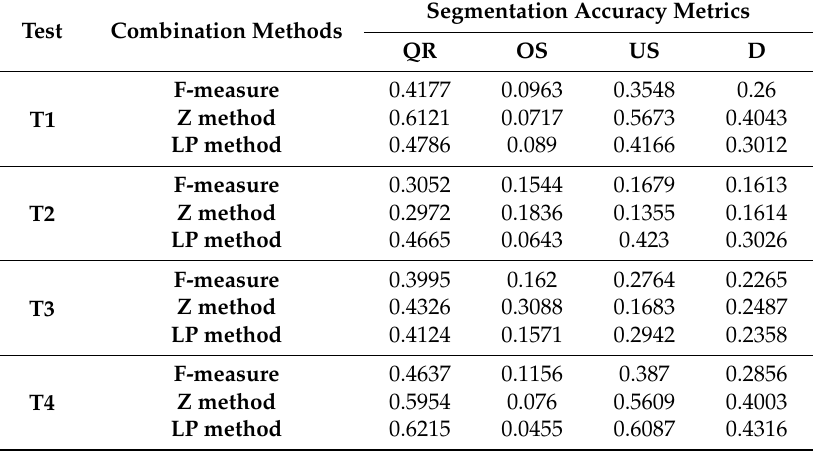
Table 1. The supervised evaluation (SE) results for the segmentations produced with the three combination